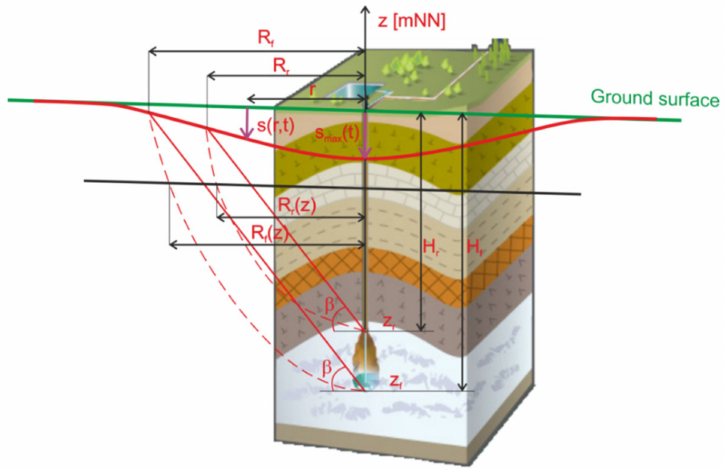
Figure 2. A subsiding trough above an exemplary salt cavern. (3D background is from https: